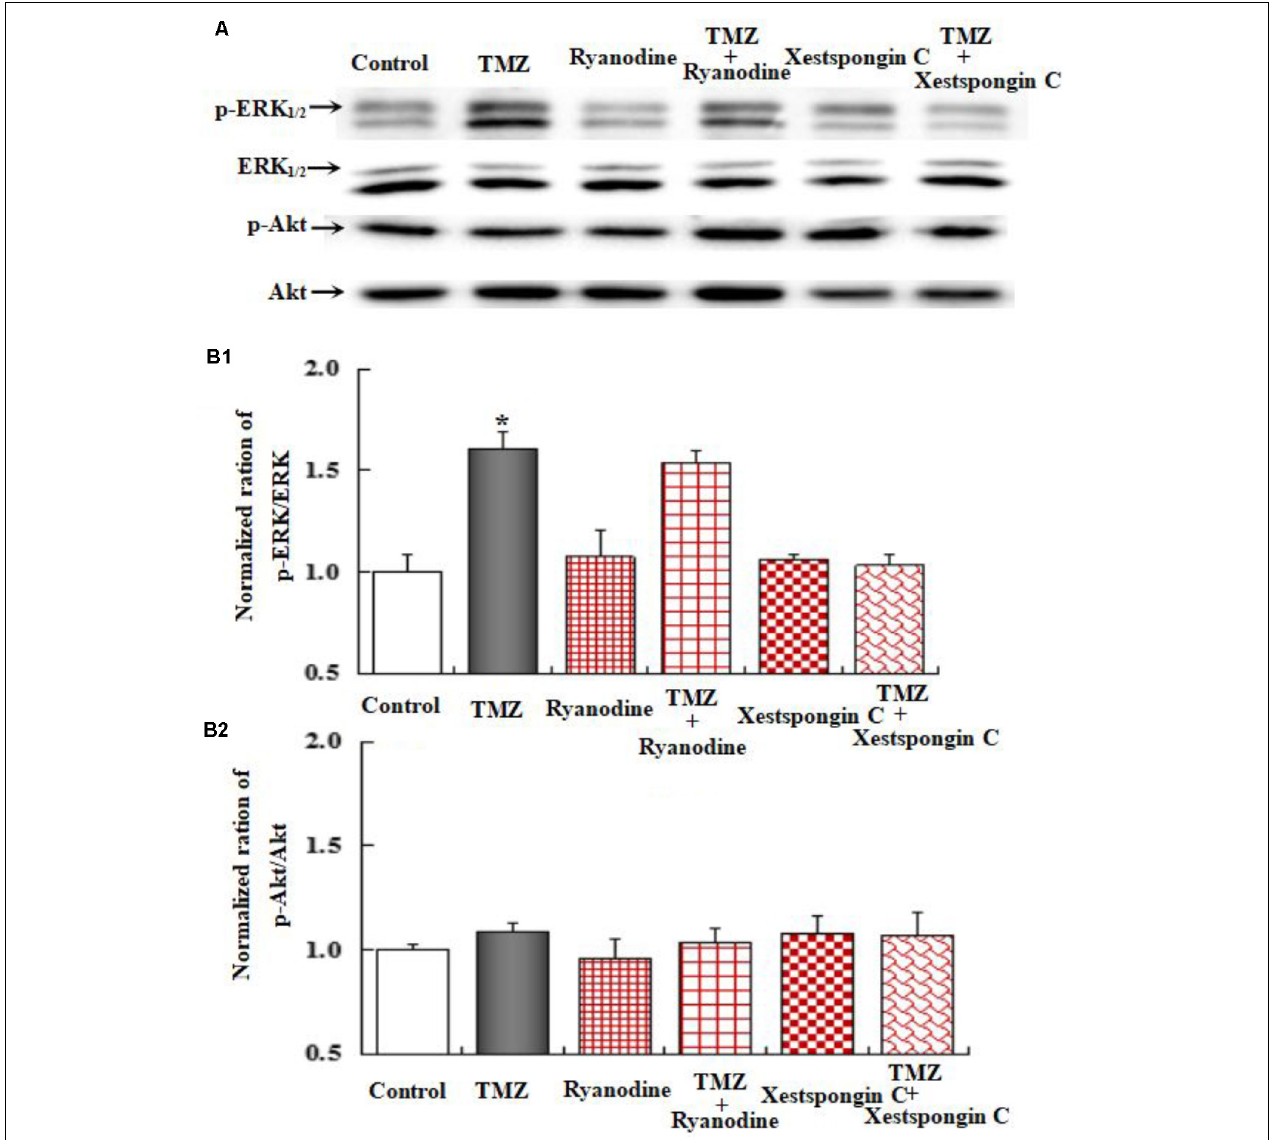
FIGURE 7 | Upregulation of TMZ-induced ERK 1 / 2 phosphorylation by IP3R in U251 cells. (A) Cells were incubated for 20 min in the absence of any drug (Control) or in the presence of 5 µ M TMZ. In some experiments, 1 µ M Xestspongin C (Xest) and 1 µ M Ryanodine (Ryan) were added as in ( Figure 6 ). (B1) Mean ERK phosphorylation was quantified as ratios between p-ERK 1 / 2 and ERK 1 / 2 . (B2) Mean Akt phosphorylation was quantified as ratios between p-Akt and Akt. Similar results were obtained from three independent experiments. SEM values are indicated by vertical bars. ∗ Indicates a statistically significant ( P < 0.05) difference from the negative control